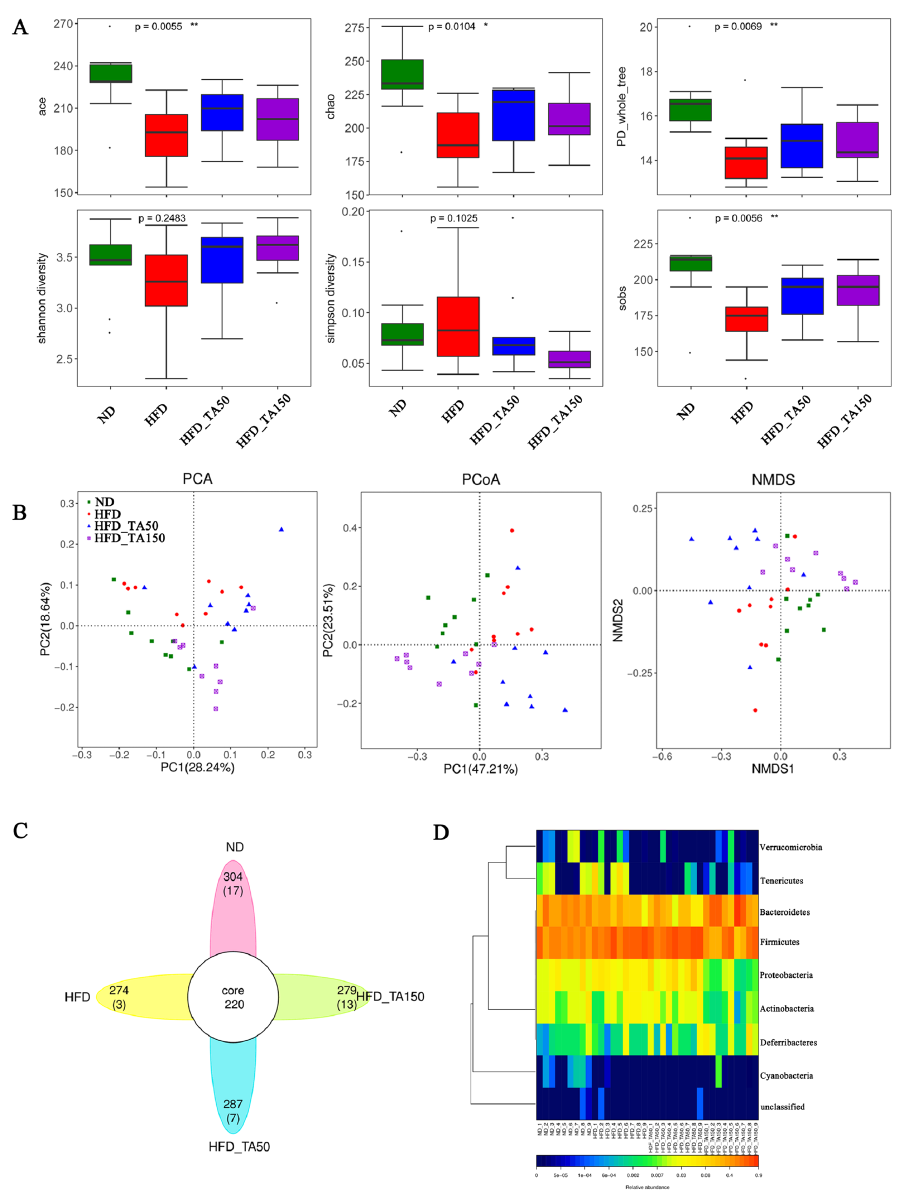
Figure 5. Effect of dietary tannic acid on gut microbial diversity. ( A ) The alpha diversity analysis (ace, chao, PD_whole_tree, Shannon diversity, Simpson diversity, sobs), ( B ) the beta diversity analysis (PCoA, PCA and NMDS), ( C ) Venn diagrams, ( D ) heatmap on phylum level. Data are expressed as mean ± SEM. Significant correlations are marked by * p < 0.05 and ** p < 0.01.